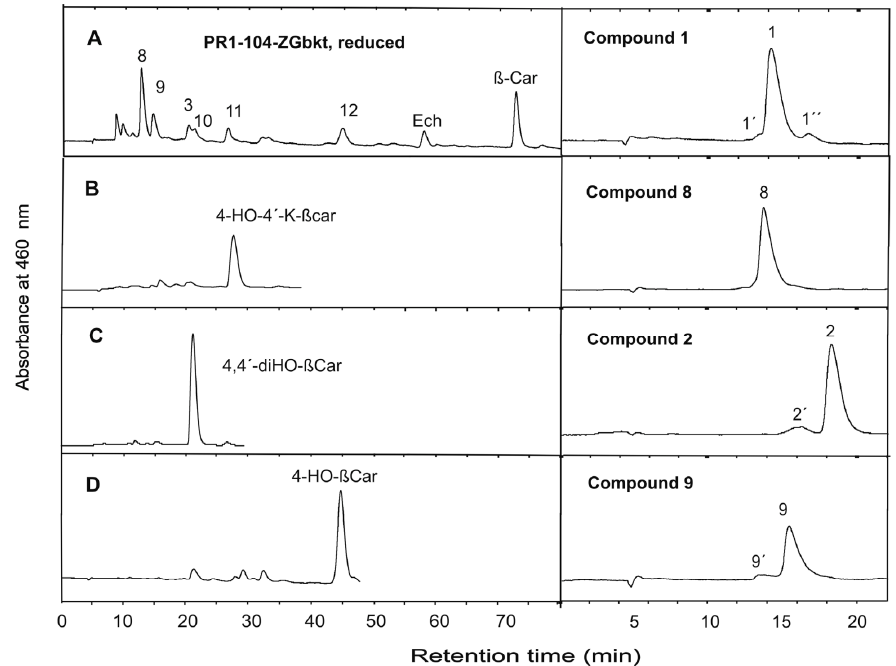
Figure 4. HPLC separation of hydroxy carotenoids after reduction ( A – D ) and isolated peaks 1 and 2 from Figure 2 and their reduction products in system II. Standards are shown in traces B – D . Abbreviations (and assignment of corresponding peaks): β -Car, β -carotene; Ech, echinenone; 4-HO- 4’-K- β car, 4-hydroxy-4’-keto- β -carotene (11); 4,4’-diHO- β Car, 4,4’-dihydroxy- β -carotene (10); 4-HO-